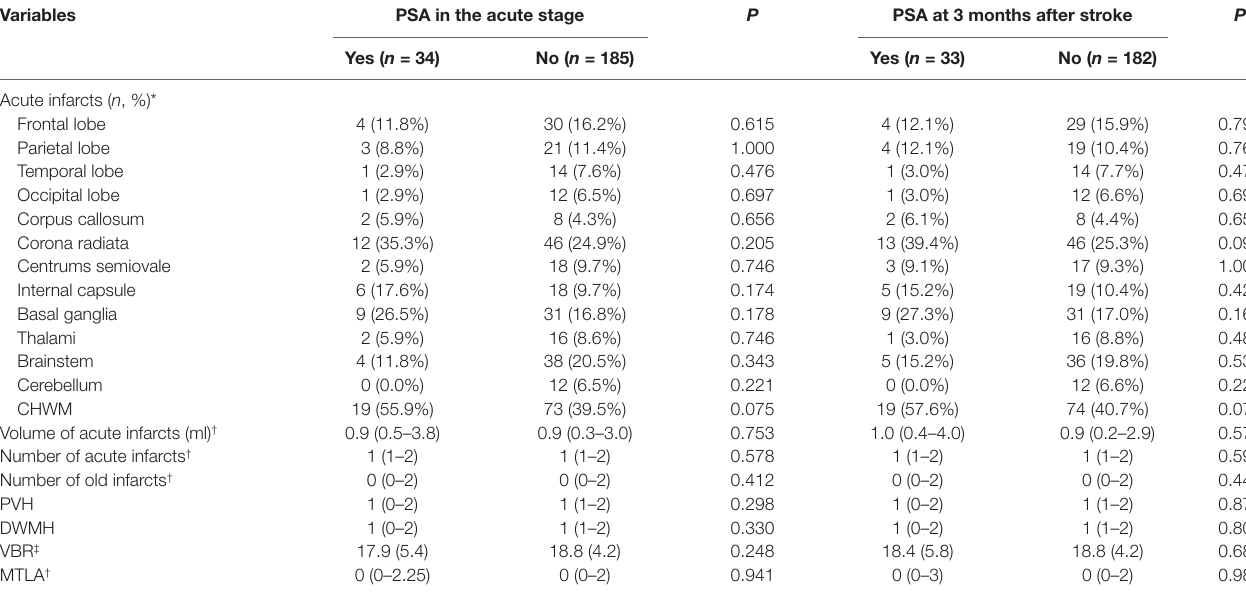
TABLE 2 | Comparisons of MRI variables between the PSA and non-PSA groups.